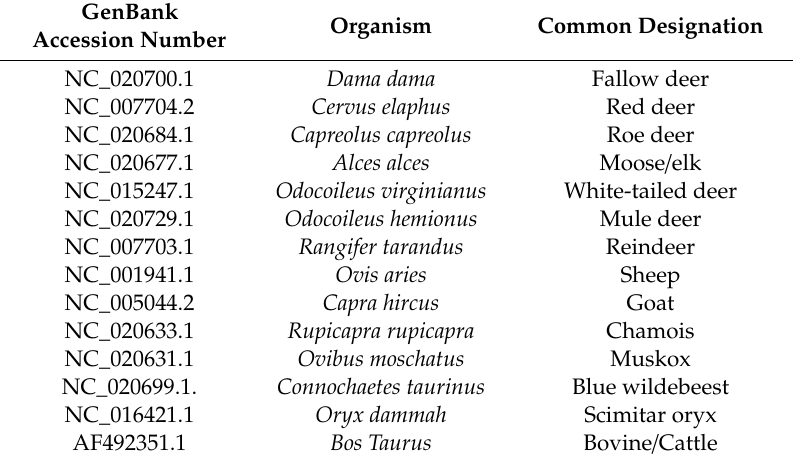
Table A1. Information on the di ff erent species within the Cervidae and Bovidae families used on this analysis and retrieved from GenBank at the National Center for Biotechnology